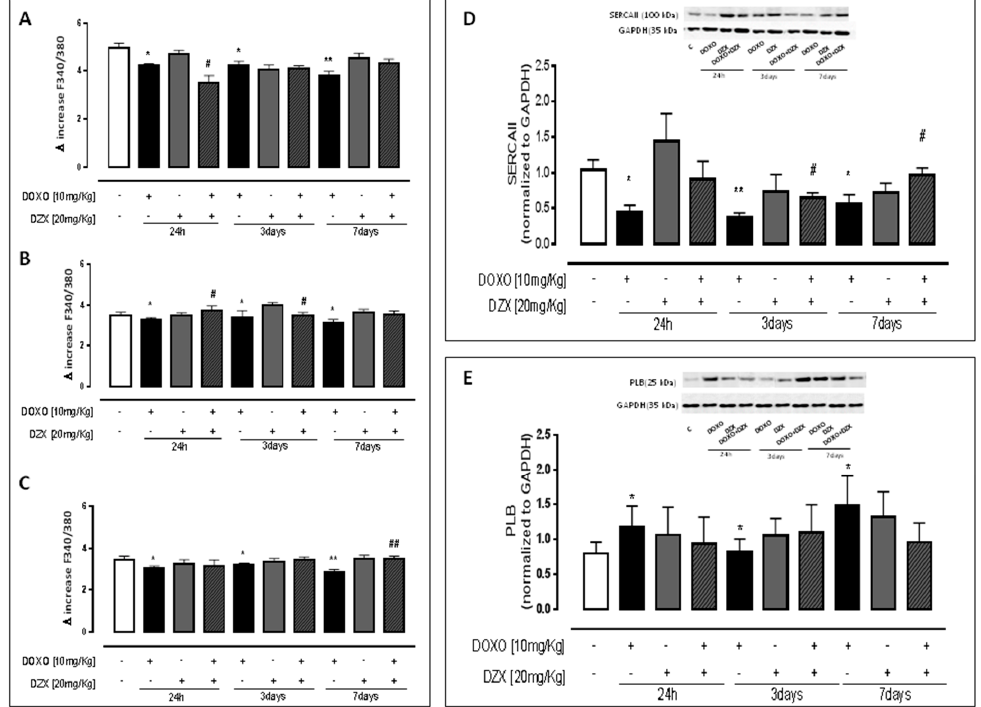
Figure 1. Effect of DOXO (10 mg/kg; i.p.) or DZX (20 mg/kg; i.p.) or combined DZX+DOXO